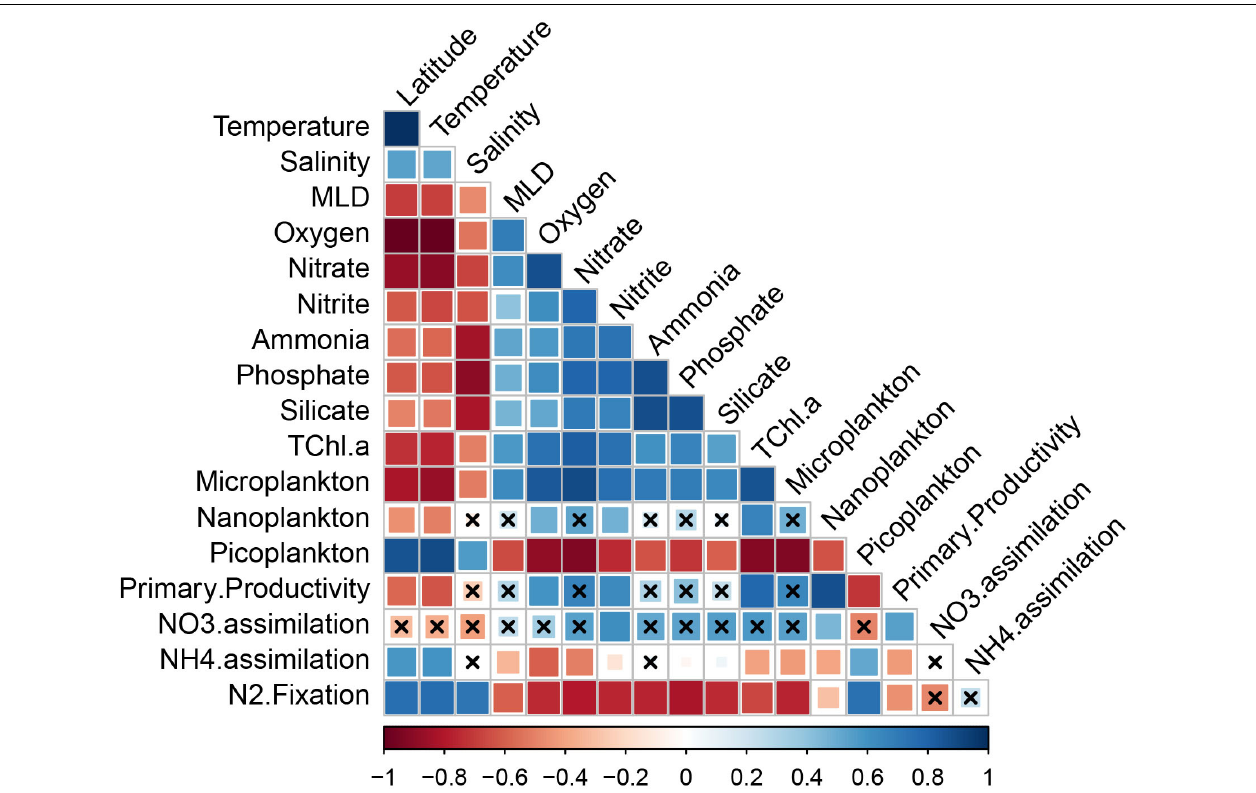
FIGURE 10 | Spearman correlation coefficients (r s ) plot including NO 3 − and NH 4 + assimilation rates, primary productivity, and N 2 fixation rates in the surface waters of the South Pacific Ocean ( n = 85). Correlations with an adjusted p -value > 0.05 are indicated by black crosses. Mixed layer depth (MLD), Total chlorophyll a (TChl.a). Positive correlations are displayed in blue and negative correlations in red. Color intensity and the size of the squares are proportional to the correlation coefficients. Primary productivity values used in the correlation plot are averages from three